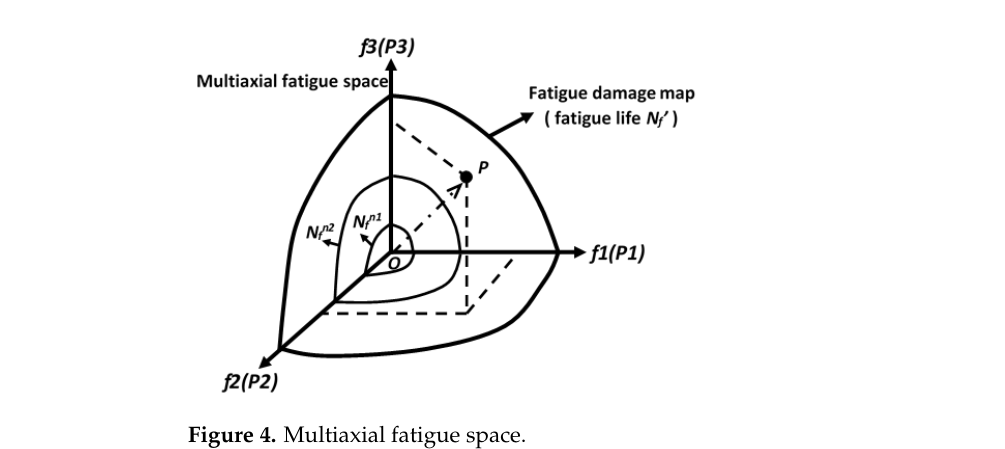
Figure 3. Material response states at different time instants.